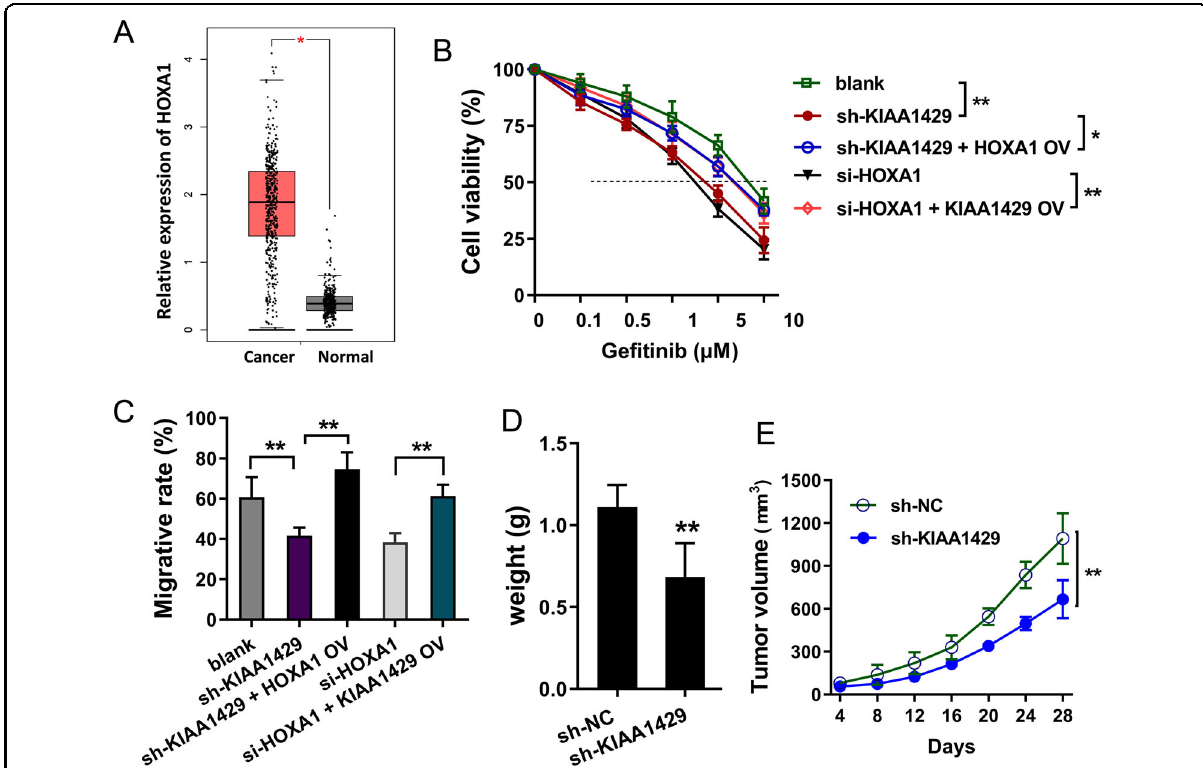
Fig. 5 KIAA1429/HOXA1 axis promoted the proliferation and ge fi tinib resistance of NSCLC cells. A HOXA1 expression was upregulated in the lung cancer cohort based on the TCGA database (http://gepia.cancer-pku.cn). B Ge fi tinib-resistant analysis was performed to detect the IC 50 value (ge fi tinib concentration causing 50% absorbance decreasing) in PC9-GR cells that transfected with KIAA1429 knockdown (sh-KIAA1429), HOXA1 overexpression (HOXA1 OV), HOXA1 knockdown (si-HOXA1), and KIAA1429 overexpression plasmid (KIAA1429 OV). C Wound-healing analysis was conducted using PC9-GR cells transfected with KIAA1429 knockdown (sh-KIAA1429), HOXA1 overexpression (HOXA1 OV), HOXA1 knockdown (si- HOXA1), and KIAA1429 overexpression plasmid (KIAA1429 OV). D Tumor weight and ( E ) volume were detected using PC9-GR cells transfected with KIAA1429 knockdown (sh-KIAA1429) and control (sh-NC). Bar graphs indicate the means ± SD. * P < 0.05, ** P <